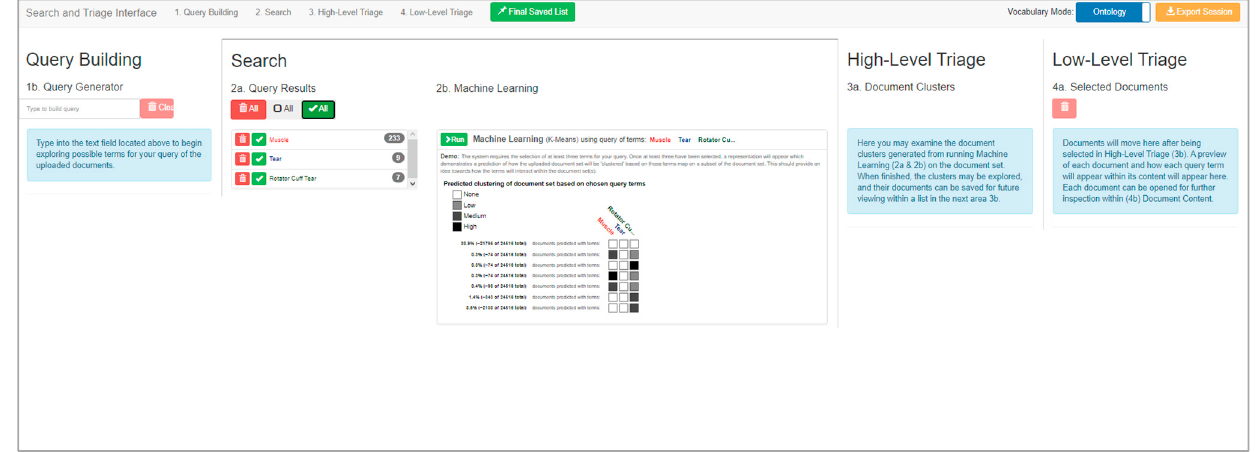
Figure 8. An overview of the Search subview within VisualQUEST.